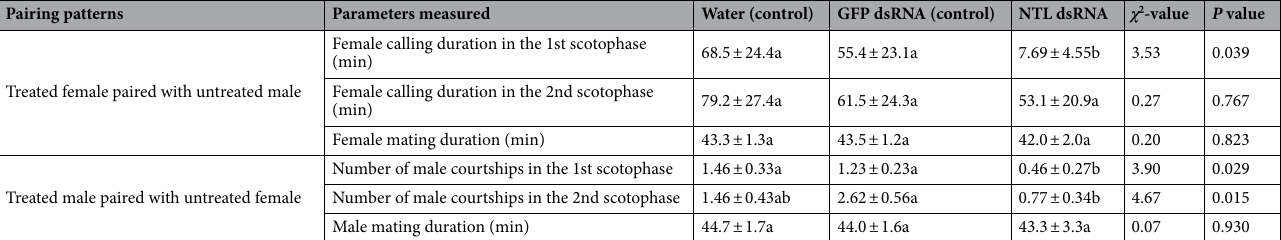
Table 3. Effects of NTL RNAi on female calling duration, number of male courtships and mating duration in S. litura. Thirteen pairs were used for each Pairing pattern. Female calling durations or the numbers of male courtships were the means of all tested females or males in the 1st or 2nd scotophase. Female or male mating durations were the means of male or female matings occurred in the first two scotophases. Data were not normally distributed even after transformation and thus were analysed using the nonparametric Kruskal– Wallis test followed by Dunn’s procedure for multiple comparisons. For each parameter (in each line), values with different letters are significantly different ( P < 0.05).